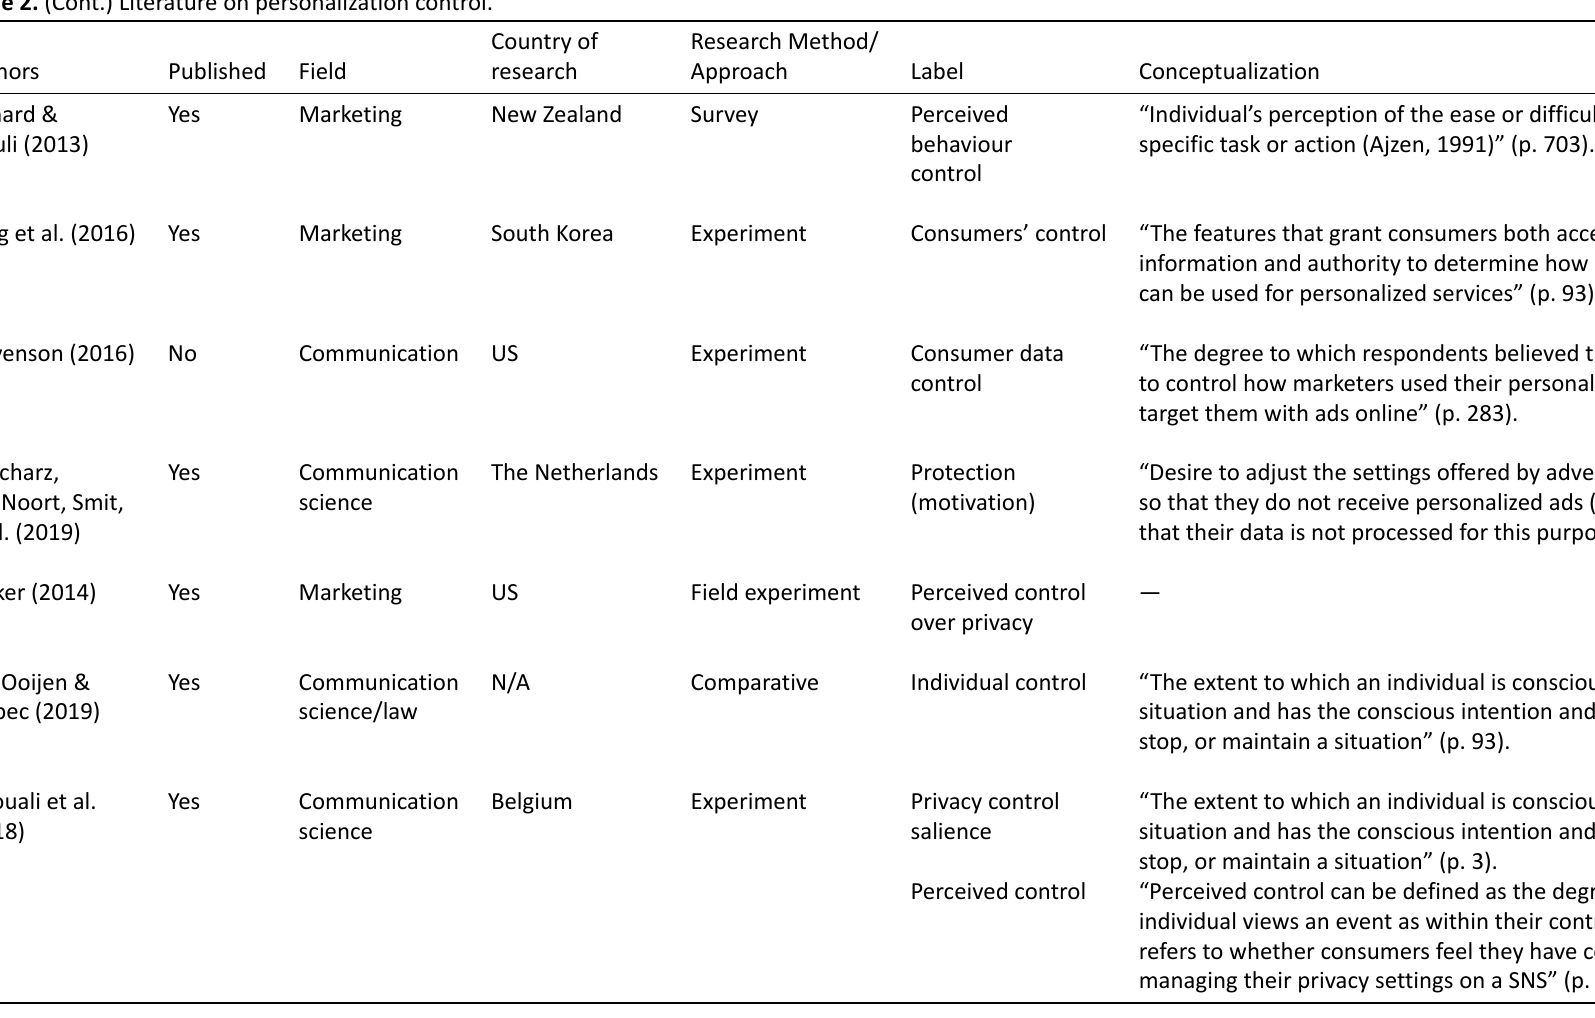
Table 2. (Cont.) Literature on personalization